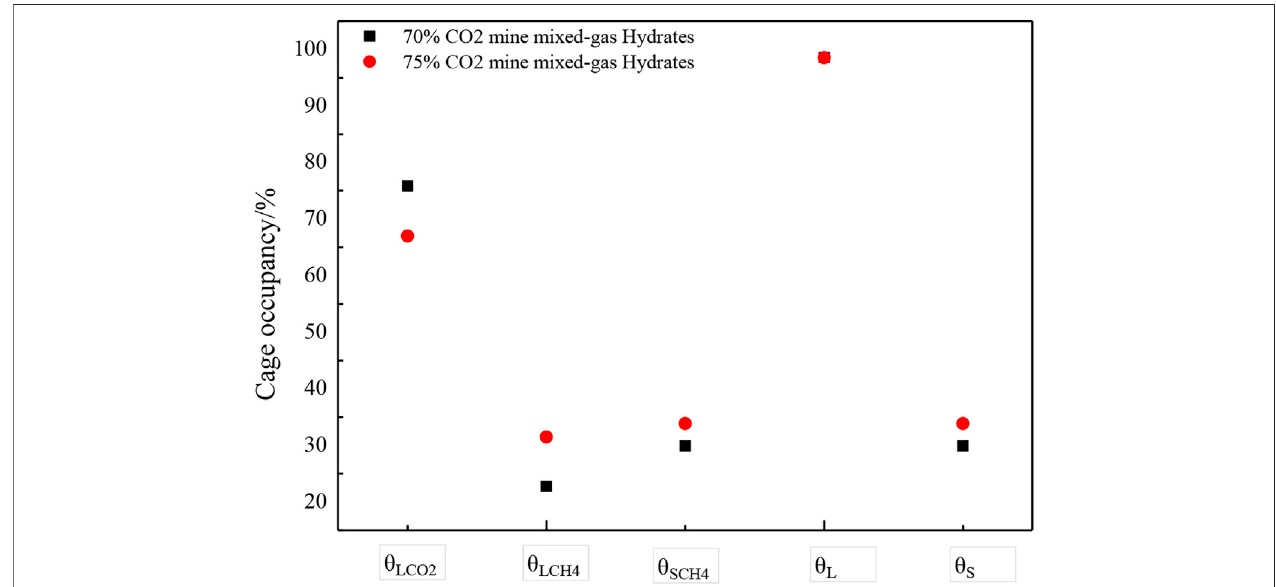
FIGURE 4 | Cage occupancy of